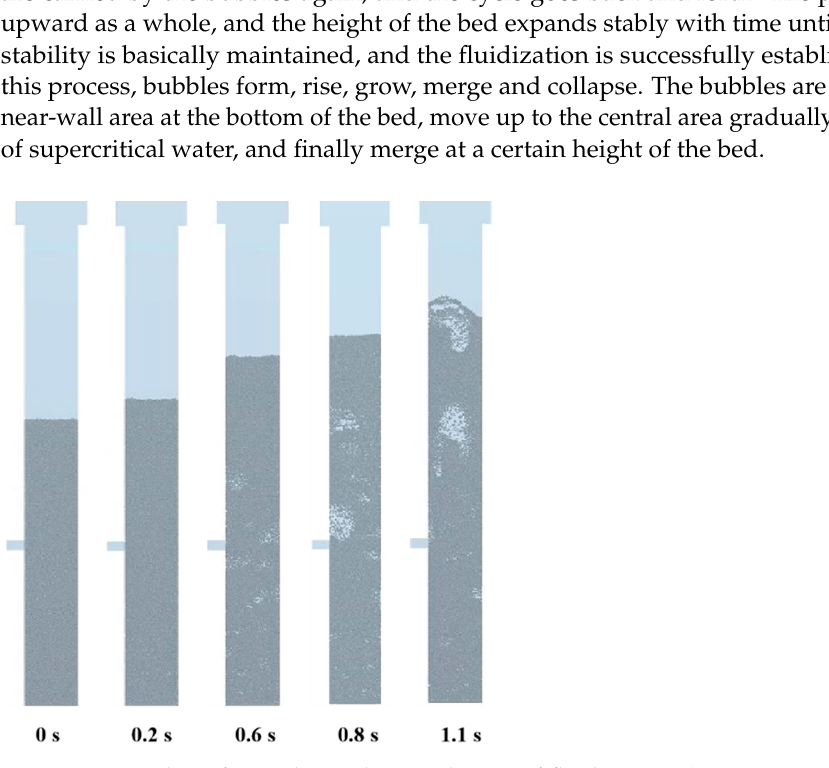
Figure 4. Snapshot of particles in the initial stage of fluidization. (Temperature of SCW, 699 K; temperature of feed, 300 K; pressure, 25 MPa; velocity of feed, 0.0262 m/s; velocity of SCW, 0.17 m/s; number of particles, 30,000).